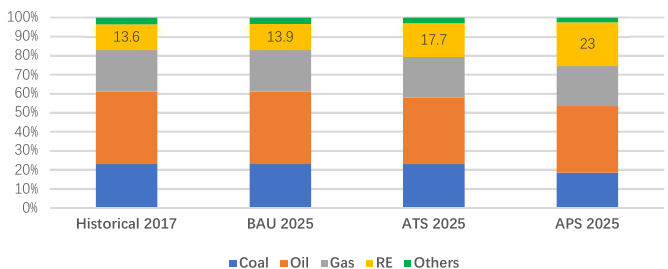
Figure 5. Energy mix under three scenarios of ASEAN. Source: The 6th ASEAN Energy Outlook